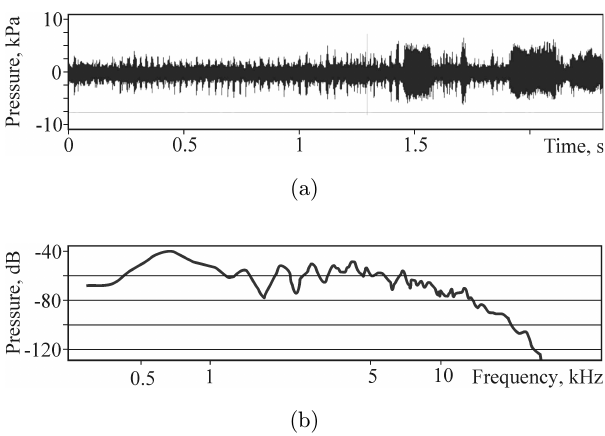
Fig. 1. Fragment of the ALIH simulator acoustic signal used to treat precipitated or sponge-embedded mesenchymal stromal cells: (a) ALIH signal and (b) signal spectrum.